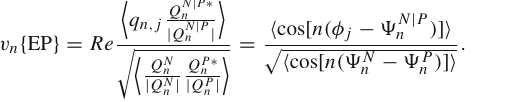
uncertainties associated with the 2PC v n measurements for selected intervals of p T and for 5–10% and 40–50% centrality bins. The contributions are expressed in %. The total systematic uncertainty is obtained by adding the contribution of the individual sources in quadrature